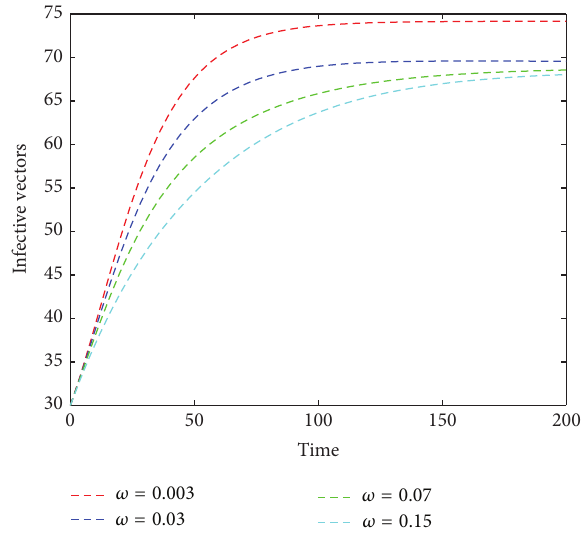
= 0.004 , 𝛽 = 0.0004 , V 1 = 0.001 , 1